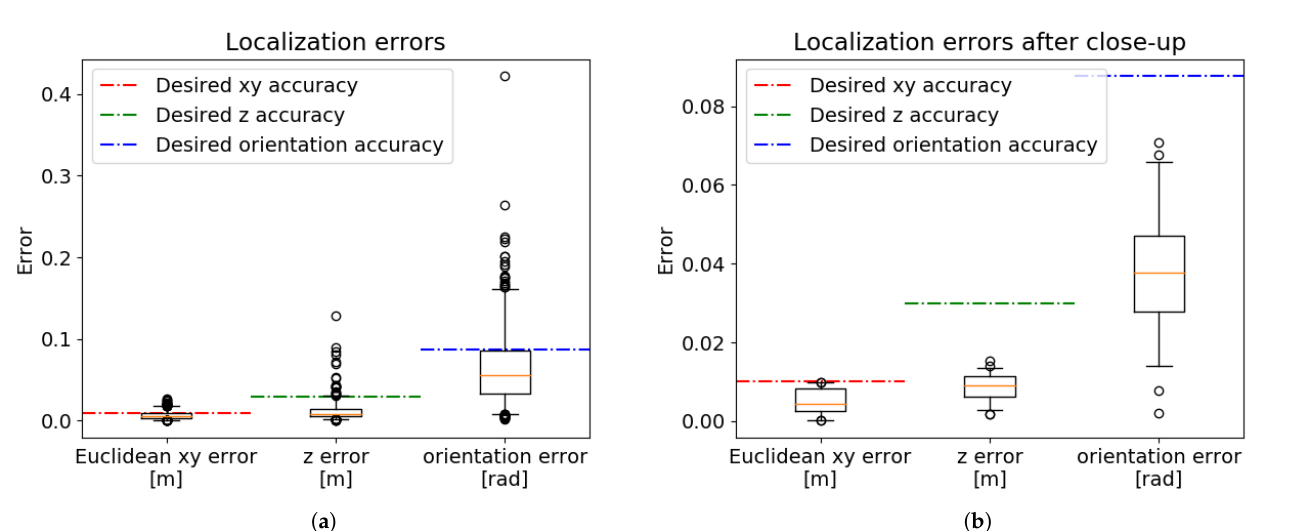
Figure 16. Results of the two-phase localization system. The results are presented using the five-number summary, with outliers (2%) depicted by circles. ( a ) All test data. ( b ) After iterative